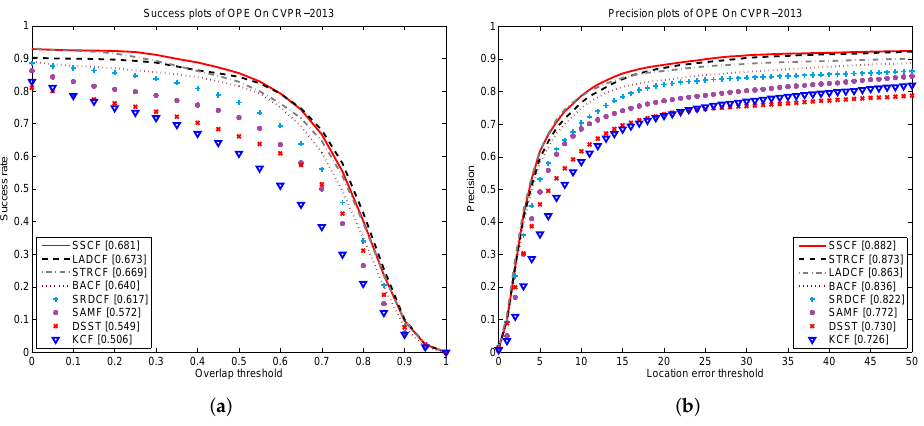
Figure 1. Success plots ( a ) and precision plots ( b ) of the proposed SSCF and other trackers on the CVPR2013